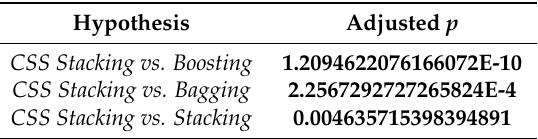
Table 7. First phase. p -values of the pair-wise comparison between CSS stacking and the other multi-classifiers.